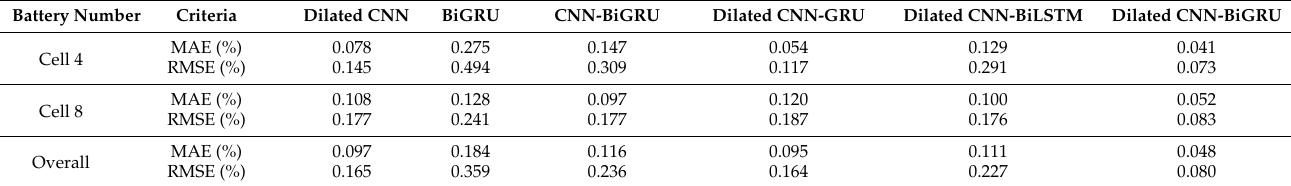
Table 3. MAEs and RMSEs of SOH estimation on the Oxford